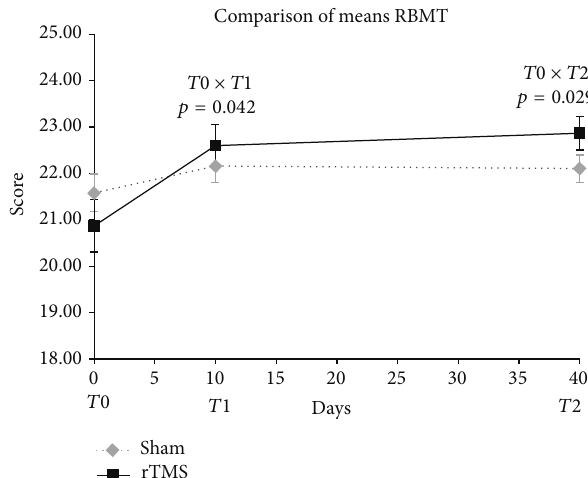
Figure 2: Comparison of RBMT means scores in T0, T1, and T2. Two-way ANOVA for repeated measures. Timing of procedures: T0: baseline cognitive assessment and 1st rTMS; T1: 10th rTMS session and 2nd cognitive assessment; T2: 30 days after T1 and 3rd cognitive assessment. Student’s 𝑡 -test for comparison of rTMS versus sham basal means, 𝑝 = 0.292 .